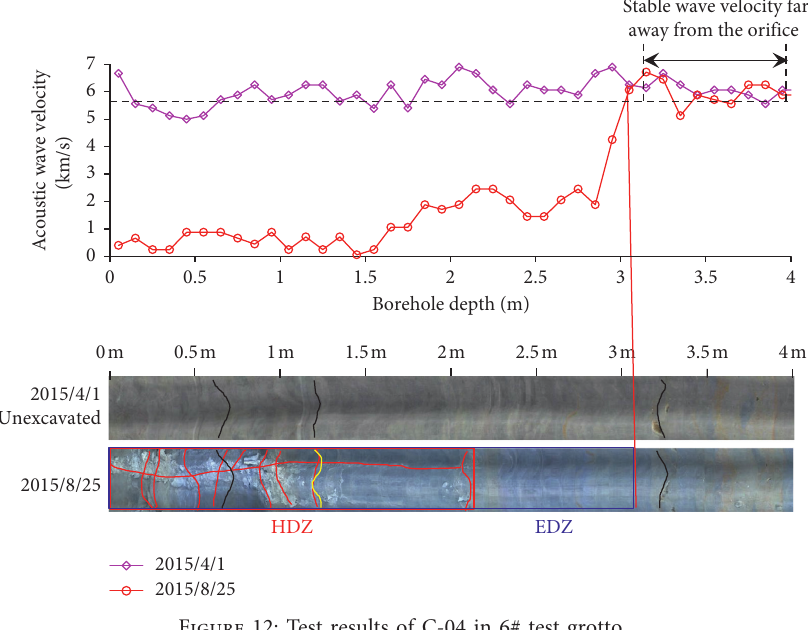
Figure 12: Test results of C-04 in 6# test